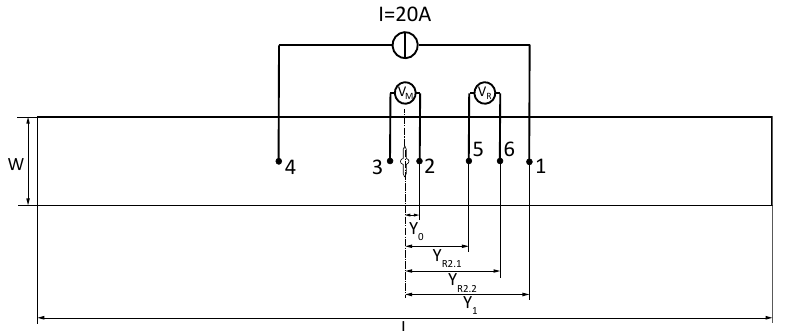
Figure 2. Positions of the welded bolts for current input and measurements. Table 3. Position of the bolts welded to the specimens for measuring signals and connecting the power supply.